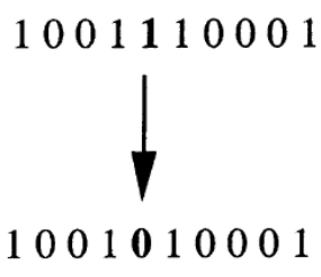
Figure 3. The binary inversion of noise.